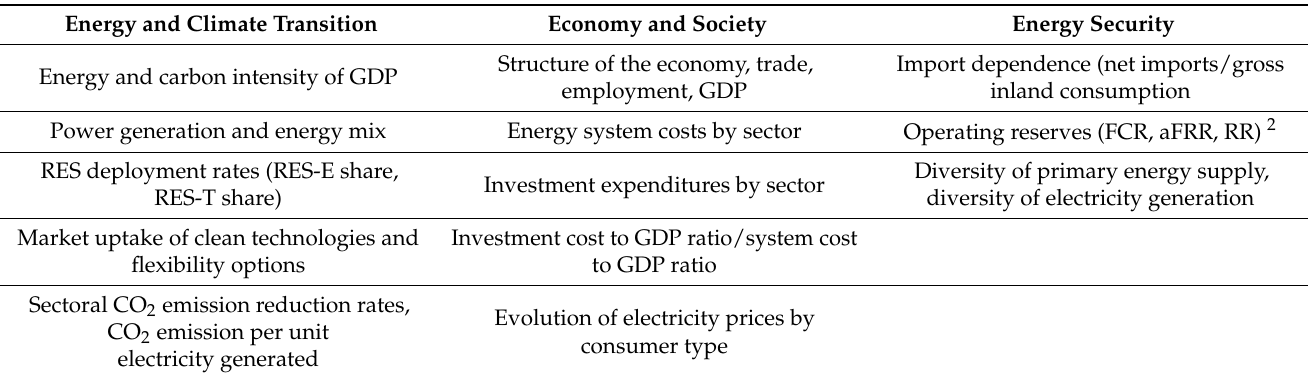
Table 2. Assessment criteria and key indicators for alternative transition scenarios